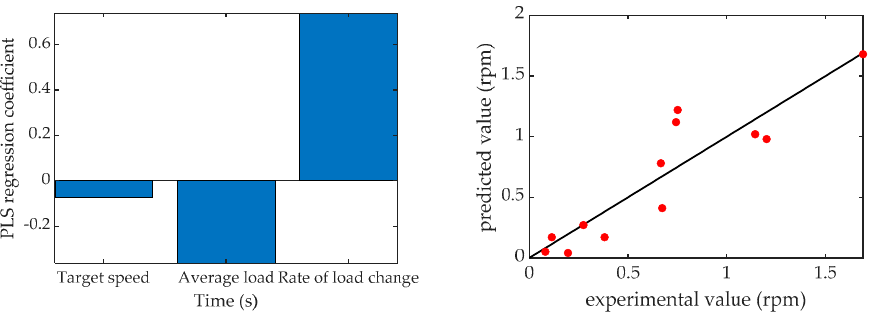
Figure 15. Influence of the parameter on the error between the average speed measured and the target speed.